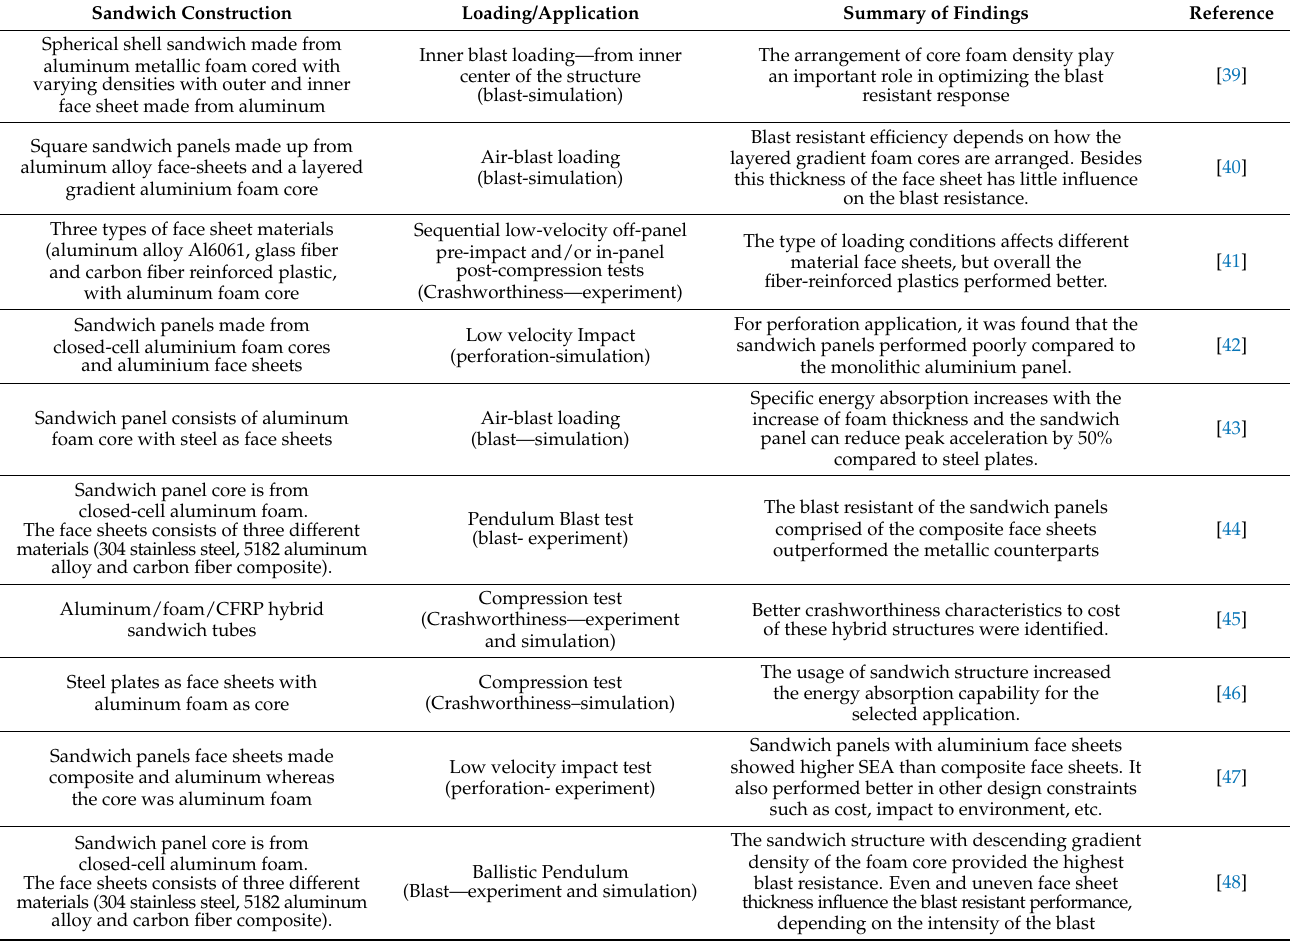
Table 2. Sandwich structure with metallic foam